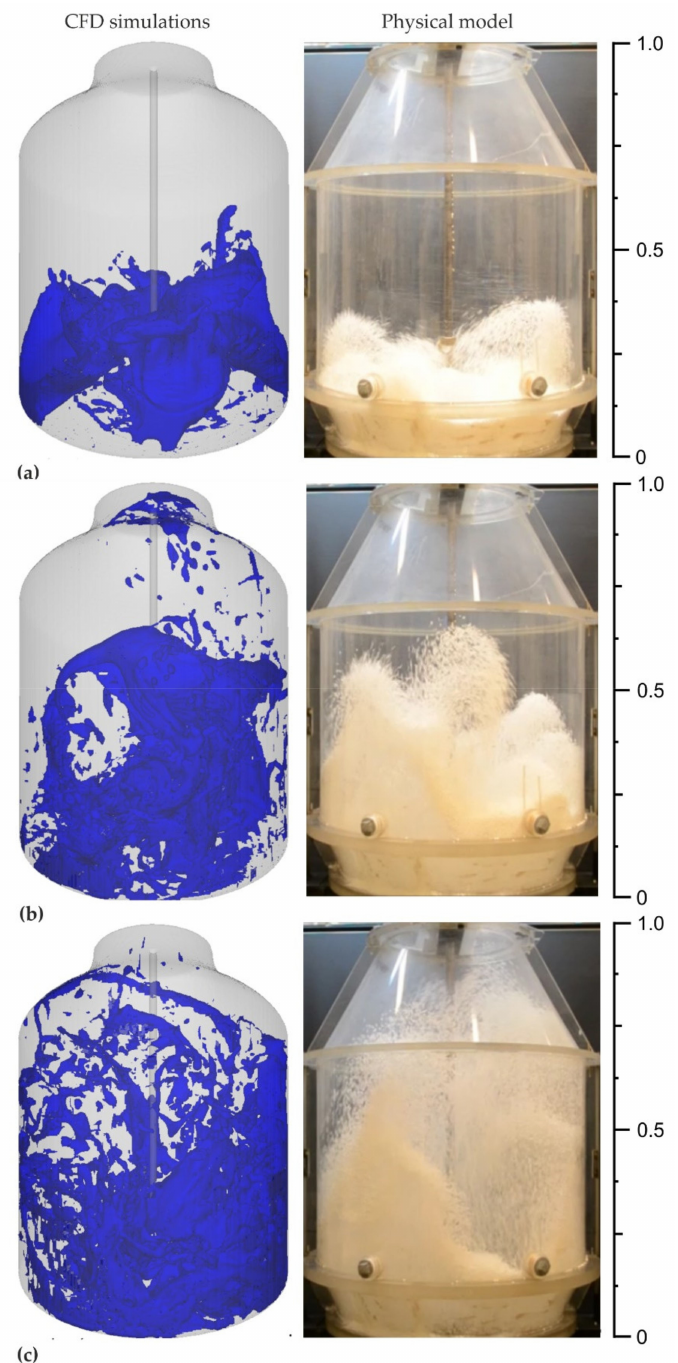
Figure 12. Verification of CFD simulations—physical model for time ( a ) 0.45 s, ( b ) 1.0 s, and ( c ) 2.35